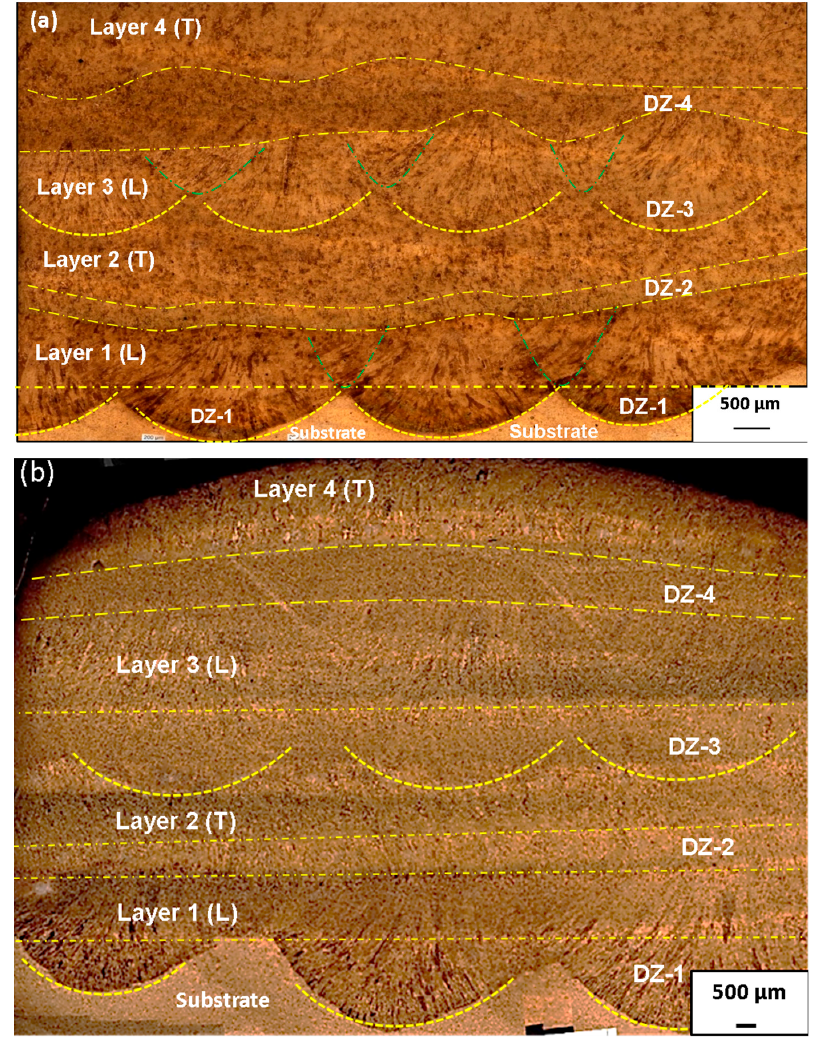
Figure 12. OM panoramic images for the WAAM-ed prismatic blocks built at ( a ) 130 (5 mm); ( b ) 330 (9 mm) at a constant OP (30%). Diffusion zone—DZ, longitudinal layer—L, transverse layer—T; green dashed lines represent turbulent zones.